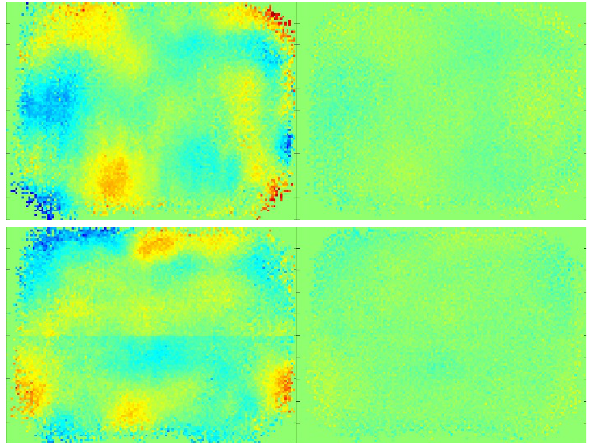
Figure 10. Superimposition of the image residuals in x (upper part) and y (lower part) coordinates. Left – a priori, right – a posteriori. A posteriori images were generated by using only the green channel. Scale: –1.5 to 1.5 µm.